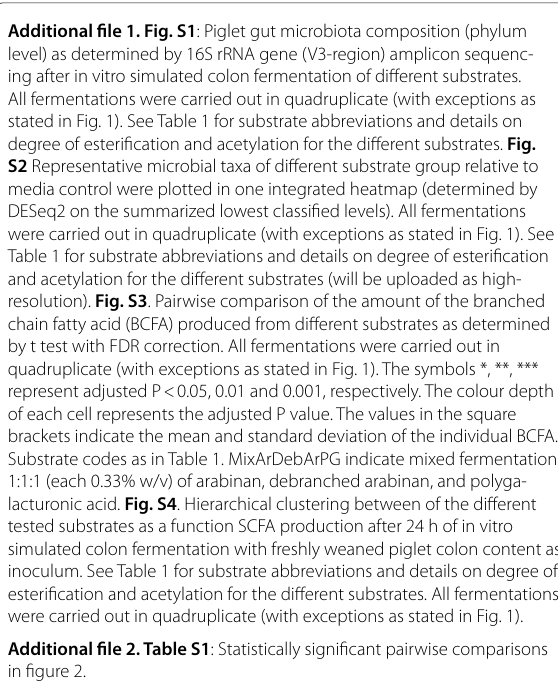
Additional file 2. Table S1 : Statistically significant pairwise comparisons in figure